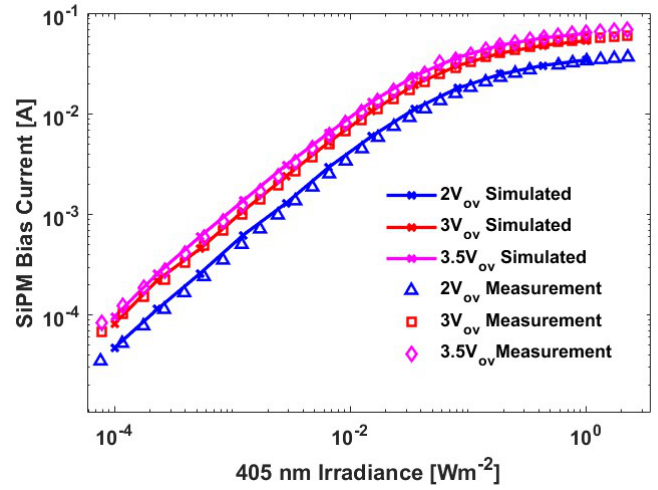
Figure 6 . A comparison of the measured and simulated currents needed to sustain three different over-voltages on a 30020 SiPM.